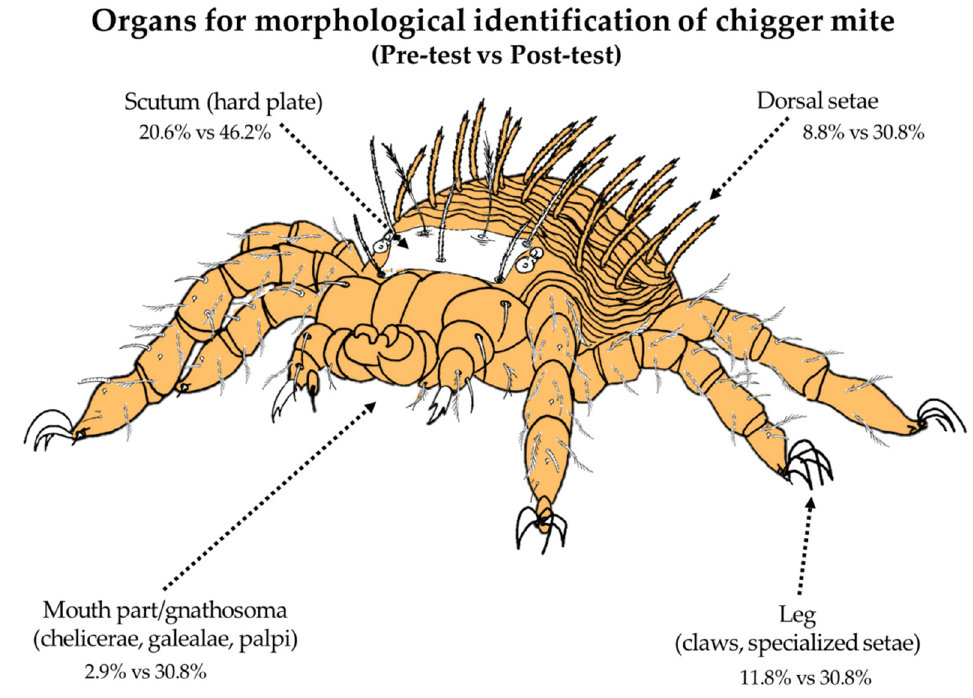
Figure 2. Morphological identification of chigger mites. Percentage shows correct answers of participants before versus after the distance learning method. Image courtesy of Rawadee Kumlert, Ph.D.